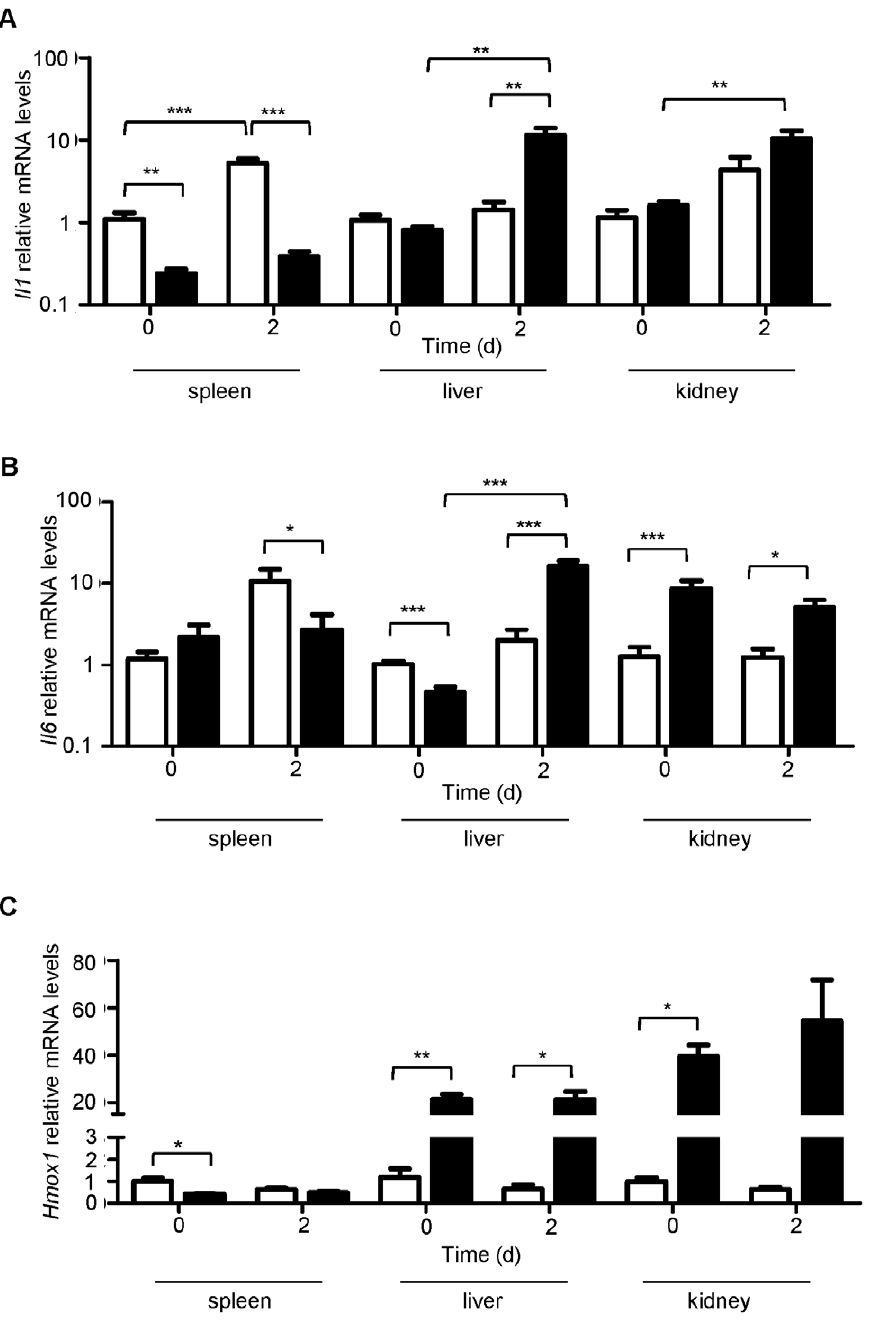
Figure 7. Cytokine profiles in 7 week-old Ank1 + / + wild type and Ank1 Ity16/Ity16 mutant mice during infection with Salmonella Typhimurium. Relative spleen, liver and kidney mRNA levels are shown for Il1 (A), Il6 (B), and Hmox1 (C) at day 0 and day 2 post infection. Ank1 + / + wild type mice (n=3) are represented by clear bar and Ank1 Ity16/Ity16 mutant mice (n=3) by a black bar. All values are compared to wild type mRNA levels at day 0 and presented on a LOG 10 scale. An * represents a P-value of less than 0.05; ** represents a P-value of less than 0.001; *** represents a P-value of less than 0.0001.